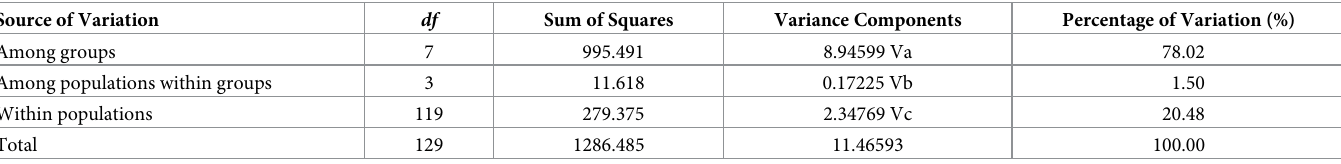
Table 3. Analysis of Molecular Variance (AMOVA) among 11 populations of R . tanezumi . Source of Variation df Sum of Squares Variance Components Percentage of Variation (%) Among